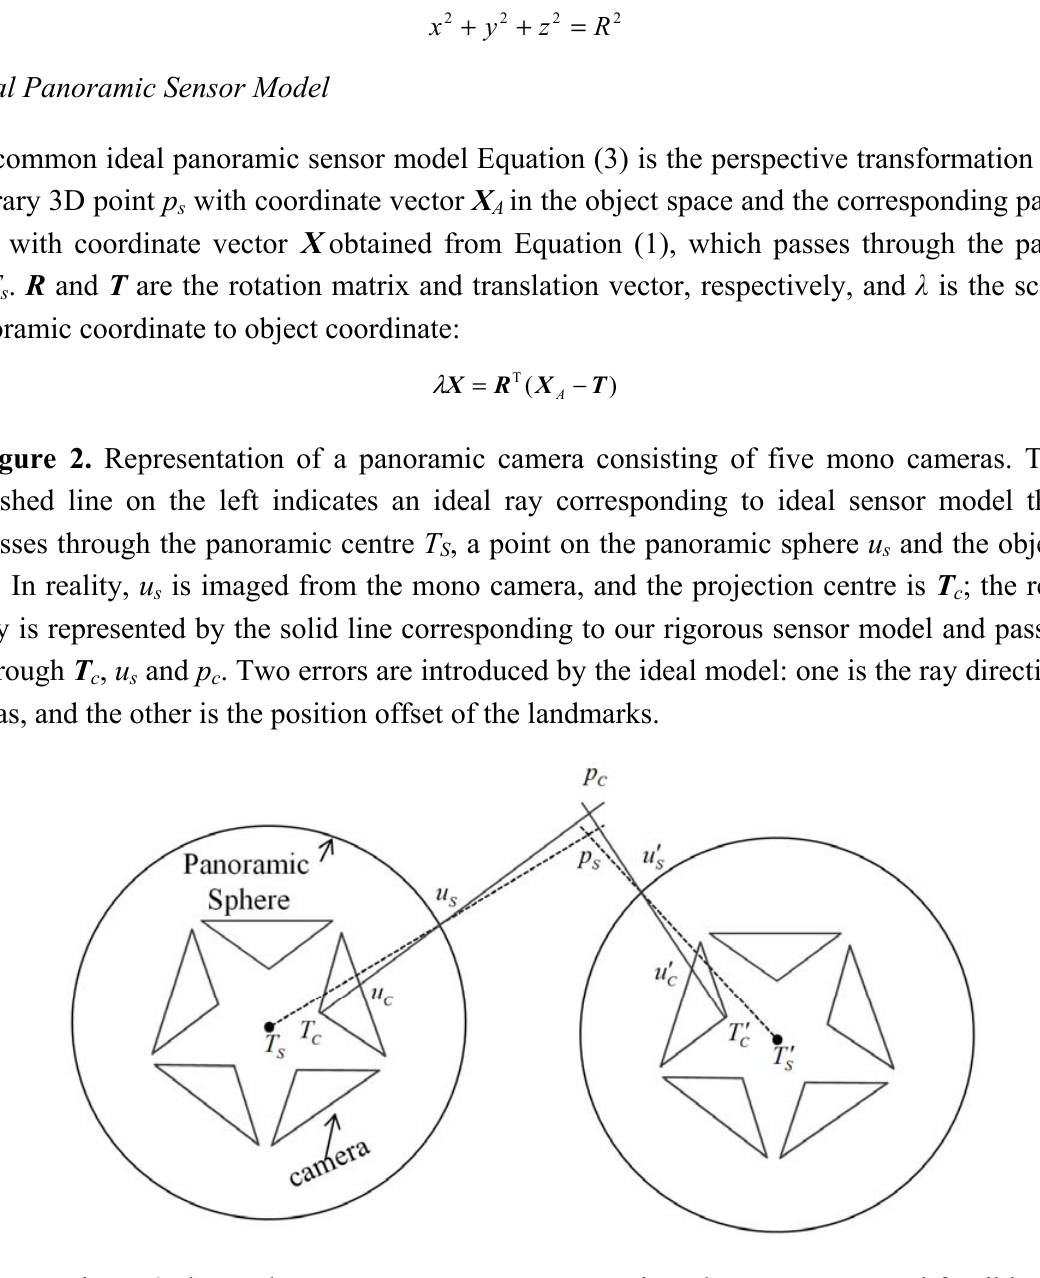
and the object s ; the real c